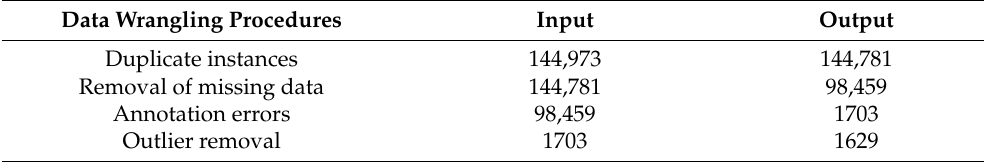
Table 2. Datawranglingproceduresappliedtothedatasetfromthemechanizedtimberharvestingoperation.